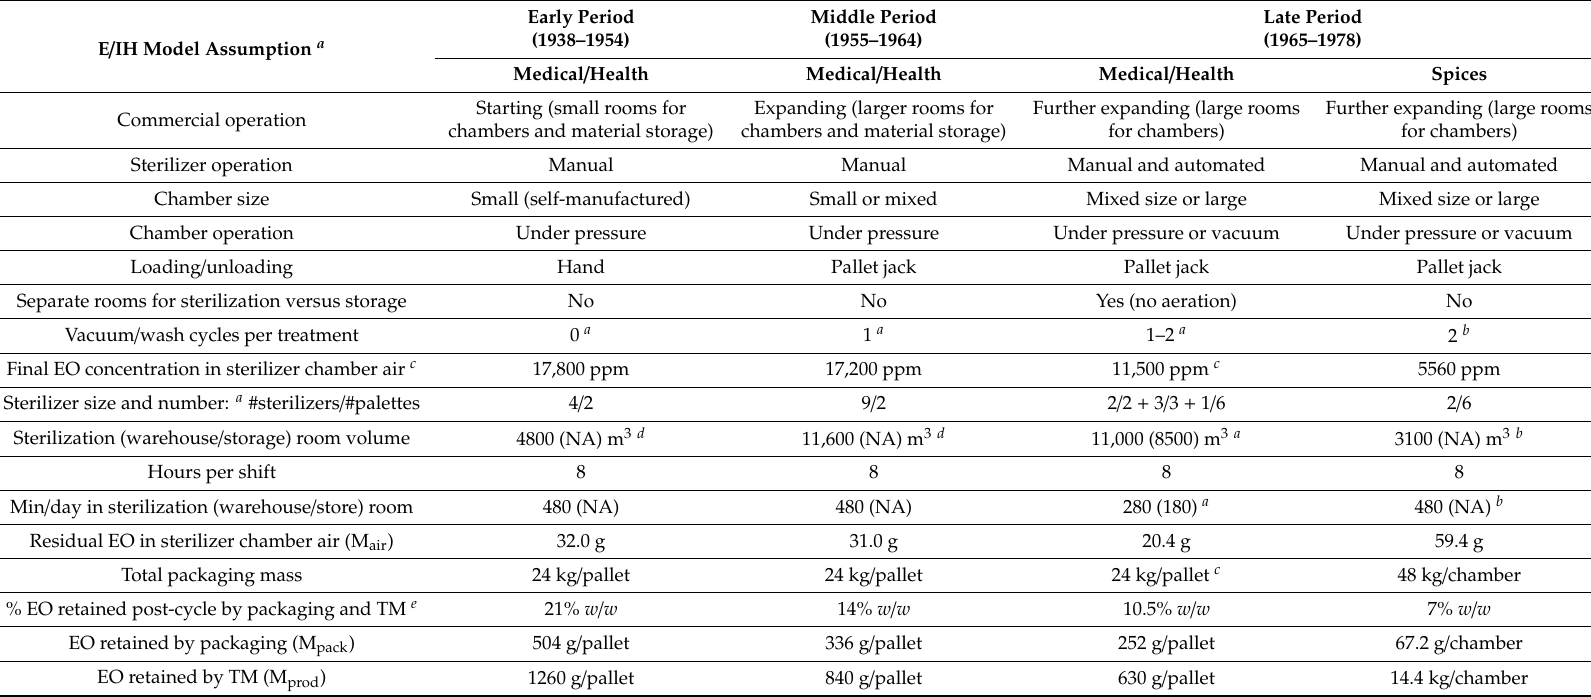
Table 3. Scenario assumptions for specific periods of E / IH model